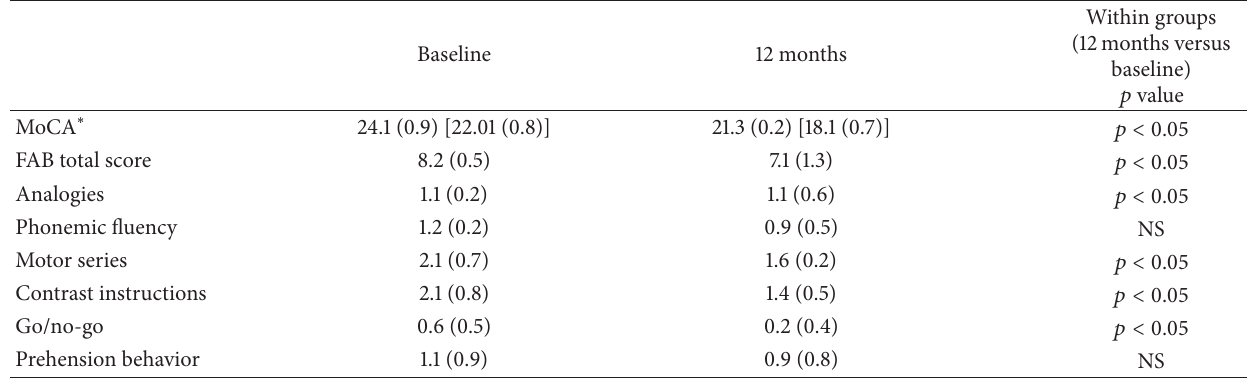
Table2:Cognitiveparametersatbaselineandat12months.Valuesaremean(SD).NS=notsignificant. ∗ MoCAarereportedasrawscores,and in square brackets corrected for the adjustments according to age and education expressed as years of schooling-Conti et al., 2015; Santangelo et al., 2015.